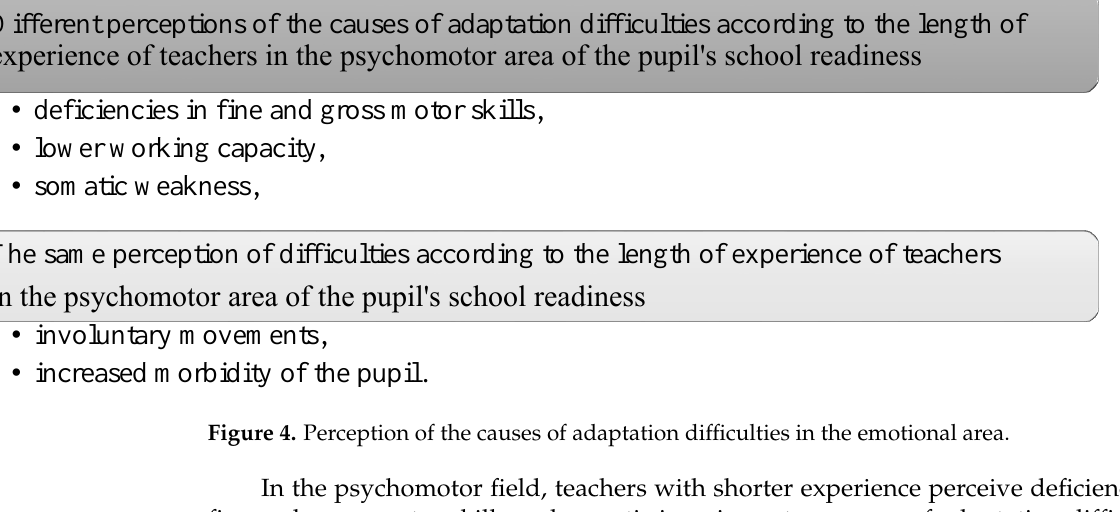
Figure 4. Perception of the causes of adaptation difficulties in the emotional area.